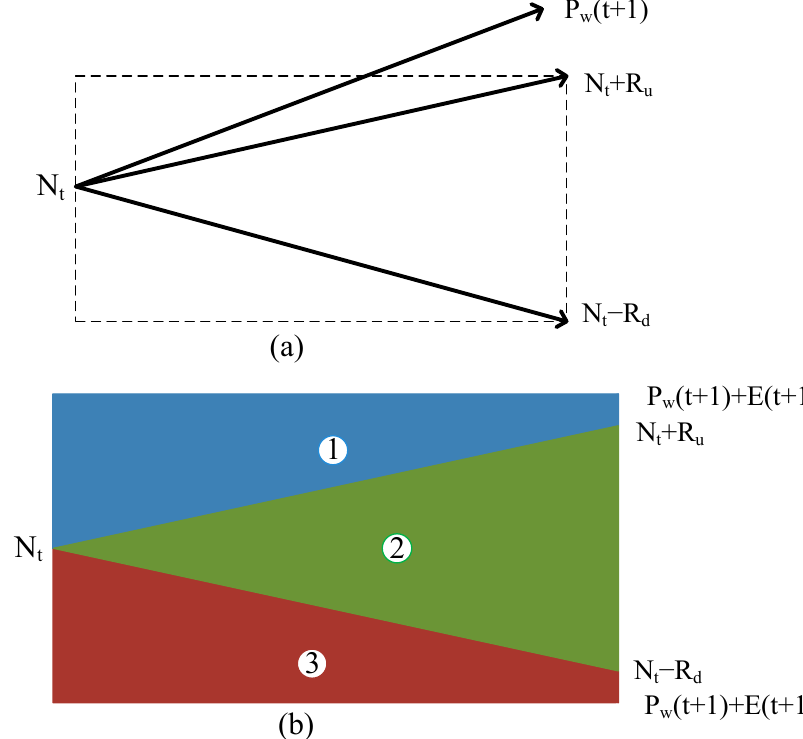
Figure 5. Operation dynamics of the BESS: ( a ) the wind blowing more than the ramp-up limit; ( b ) the three possible regions where the BESS might operate.